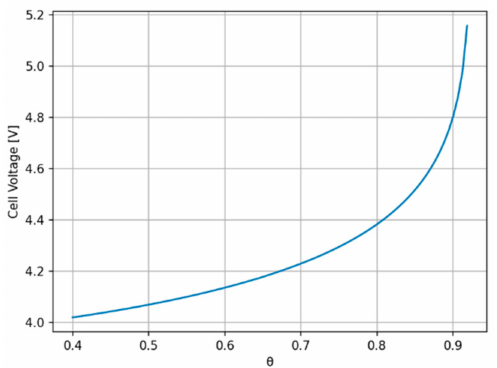
Figure 3. Cell voltage for different anode coverage